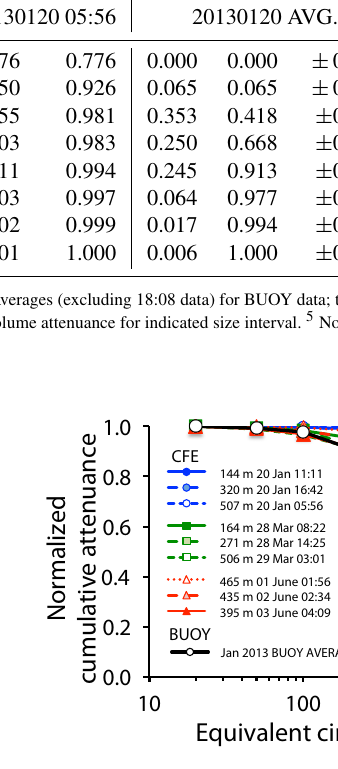
Table 2. Volume attenuance size distributions for CFE and BUOY-OSR samples from January 2013. Diameter 1